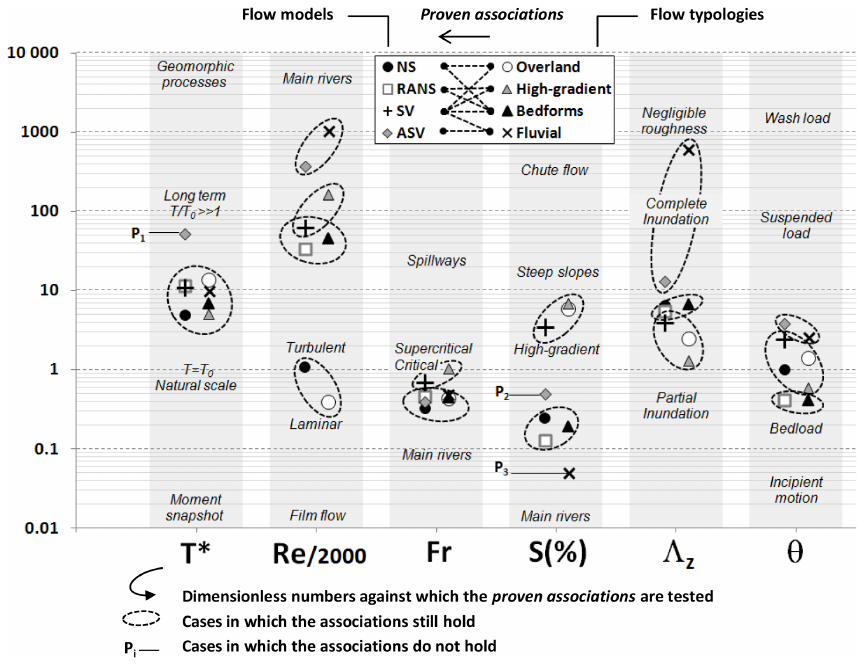
Figure 10. Comparative overview of the median values of the six selected dimensionless numbers (dimensionless period T ∗ = T/T 0 , ratio of the chosen timescale to the “natural” timescale of the flow, Reynolds number Re , Froude number Fr , slope S , inundation ratio (cid:51) z , and Shields parameter θ ) obtained for the use of systems of equations (NS, RANS, SV, and ASV) and the description of flow typologies (O, Hg, B, and F) in the cited literature. The expected associations are indicated by dotted connecting lines in the legend box. The confirmed associations are indicated by dotted ellipses. Broken associations (isolated points P i ) are discussed in the text. The typical and extreme ranges of the mentioned dimensionless numbers have been added for indication. This figure was assembled from information available in the studies cited in Appendix